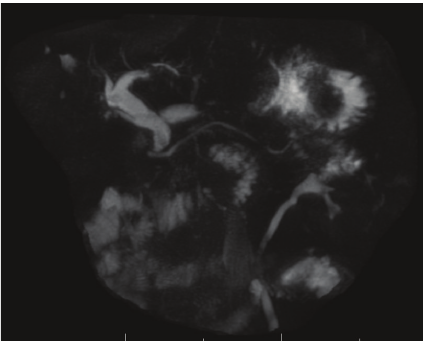
Figure 1: MRCP revealed dilated CBD with a large ( 1.5 cm × 0.55 cm × 0.5 cm) stone in the distal part.